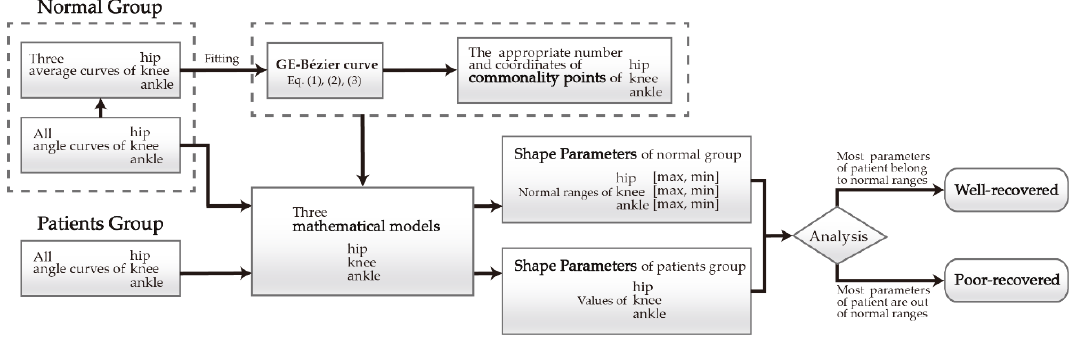
Figure 3. The process of investigating the mathematical models of three joints and obtaining the shape parameters of normal group and patient group, thus analyzing whether the patient is well recovered or poor recovered.